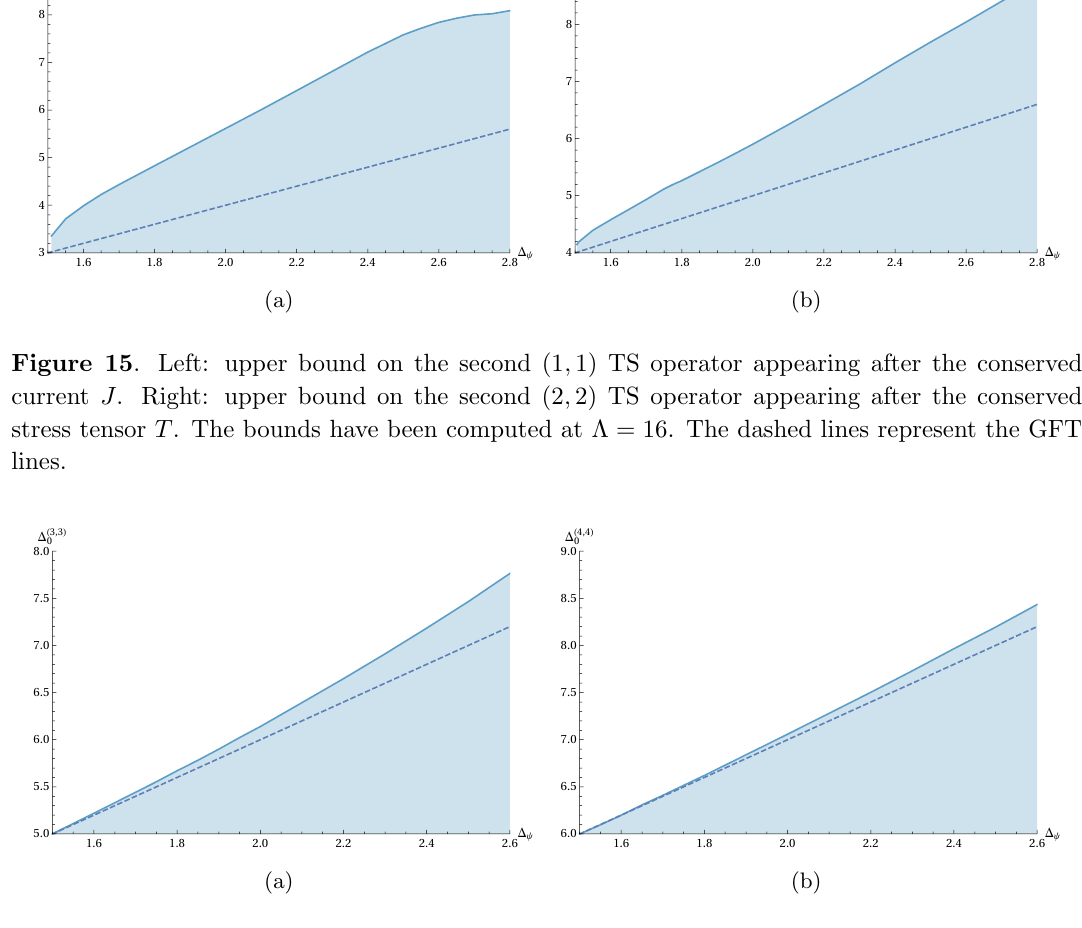
Figure 16 . Left: upper bound on the dimension of the neutral (3 ; 3) TS operator. Right: upper bound on the (cid:12)rst neutral (4 ; 4) TS operator. The shaded region is the allowed one. The bounds have been computed at (cid:3) = 16. The dashed lines represent the GFT